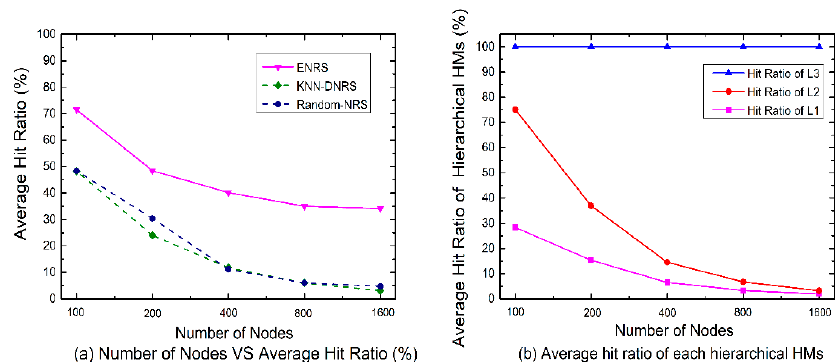
Figure 7. The comparison of average hit ratio. ( a ) demonstrate the variation tends of average hit ratio with different number of nodes in ENRS, KNN-DNRS and Random-NRS. ( b ) shows the variation of average hit ratio of each hierarchical HMs in ENRS with different number of nudes.